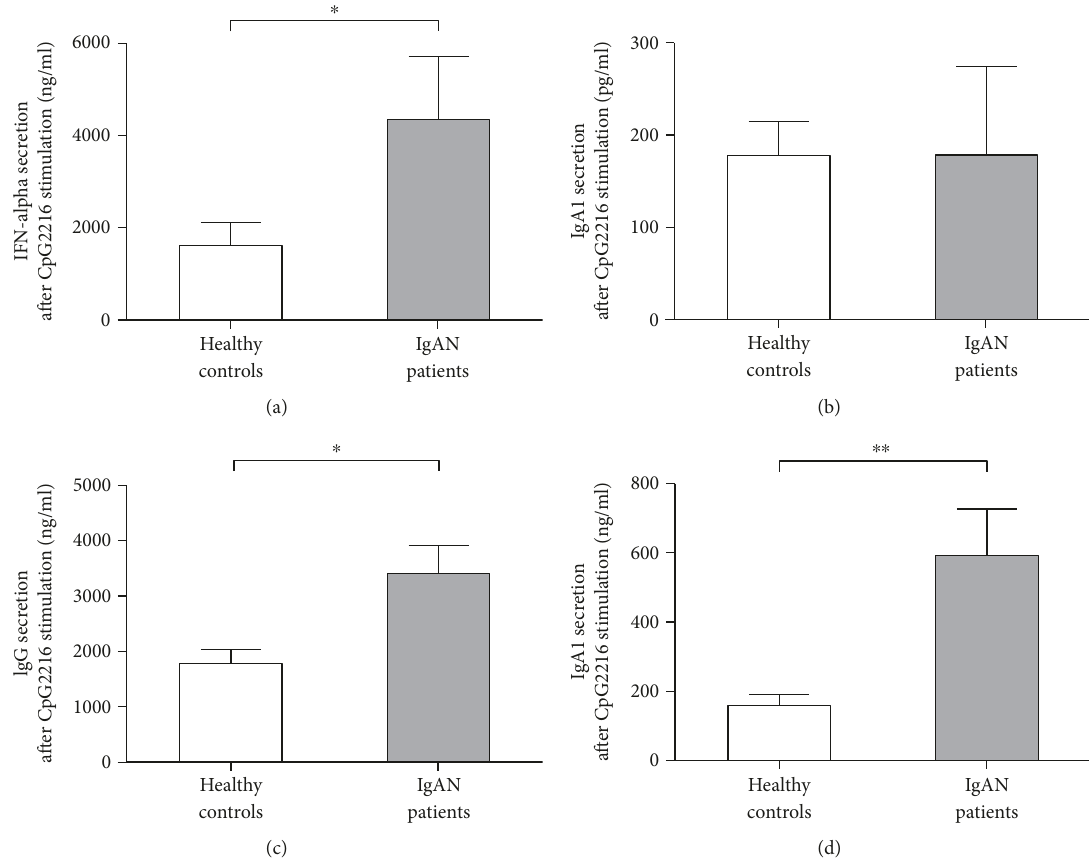
Figure 3: Secretion of IFN- α was increased in PBMCs of patients of IgAN after CpG2216 stimulation. PBMCs of di ff erent donors (healthy donors, n = 23 ; IgAN patients, n = 14 ) were prepared by fi coll-paque density centrifugation and cultured with pDC-preferred CpG2216 for di ff erent days, and the supernatant samples were collected for measuring IFN- α , IgA1, IgA2, and IgG levels. ∗ p < 0 05 ; ∗∗ p < 0 01